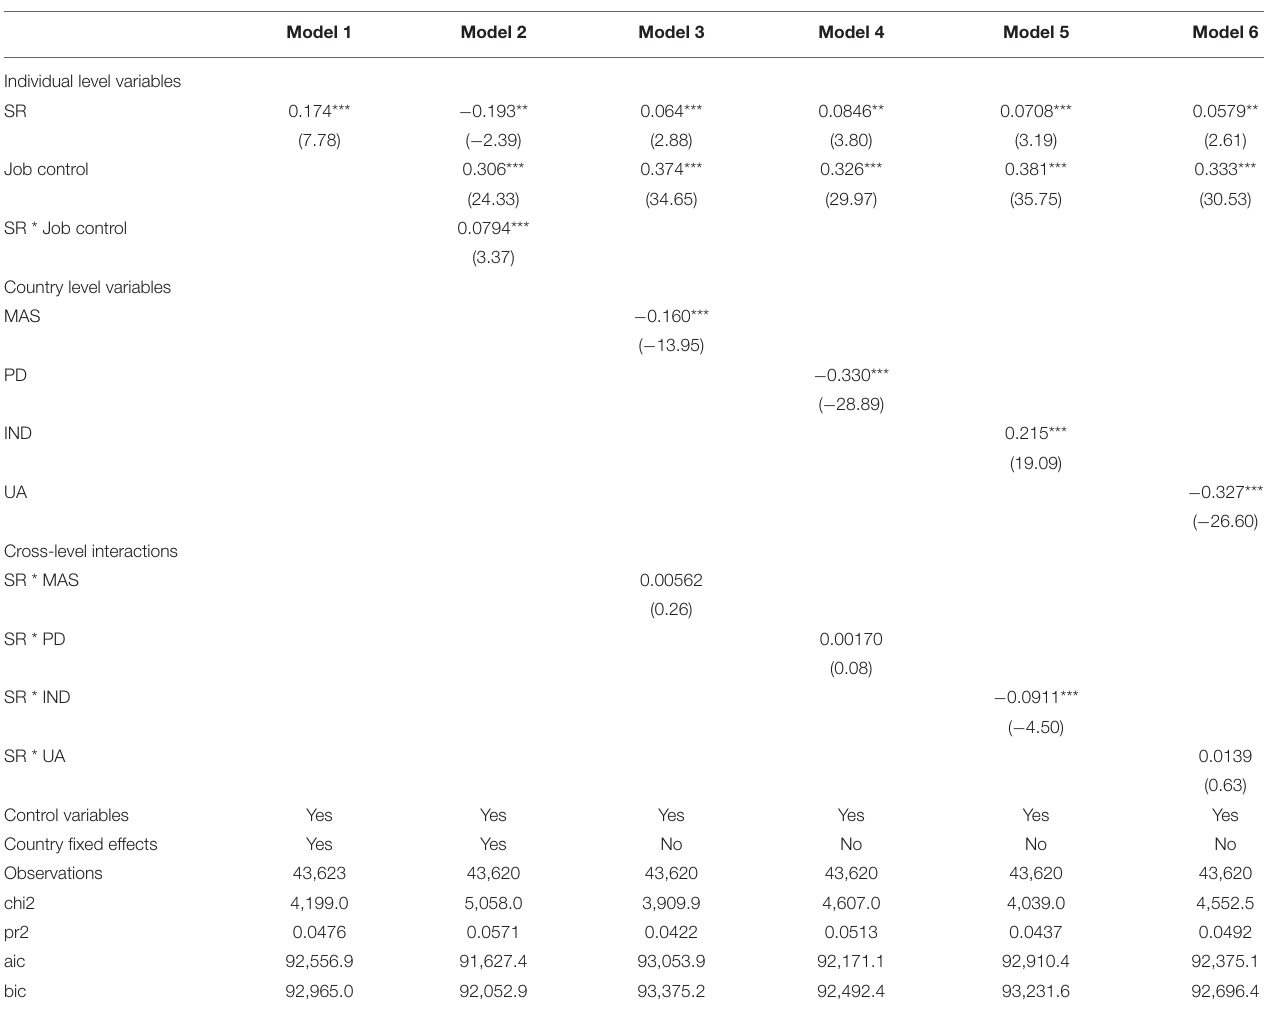
TABLE 2 | Ordered logit estimations for job